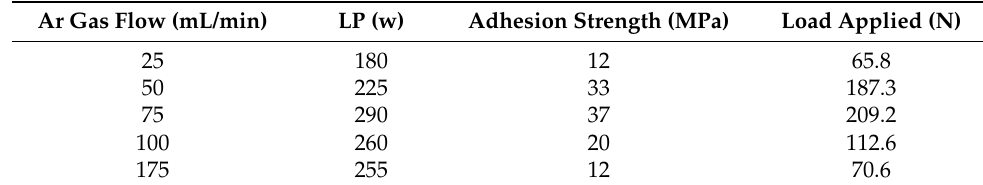
Table 4. Adhesion properties of DLN films on UHMWPE substrate [96].